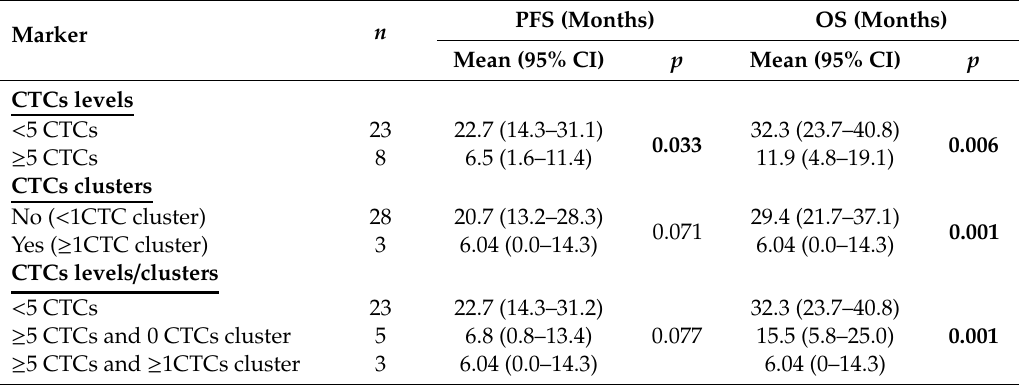
Table 2. Prognosis value of circulating tumor cell (CTC) levels in TNBC